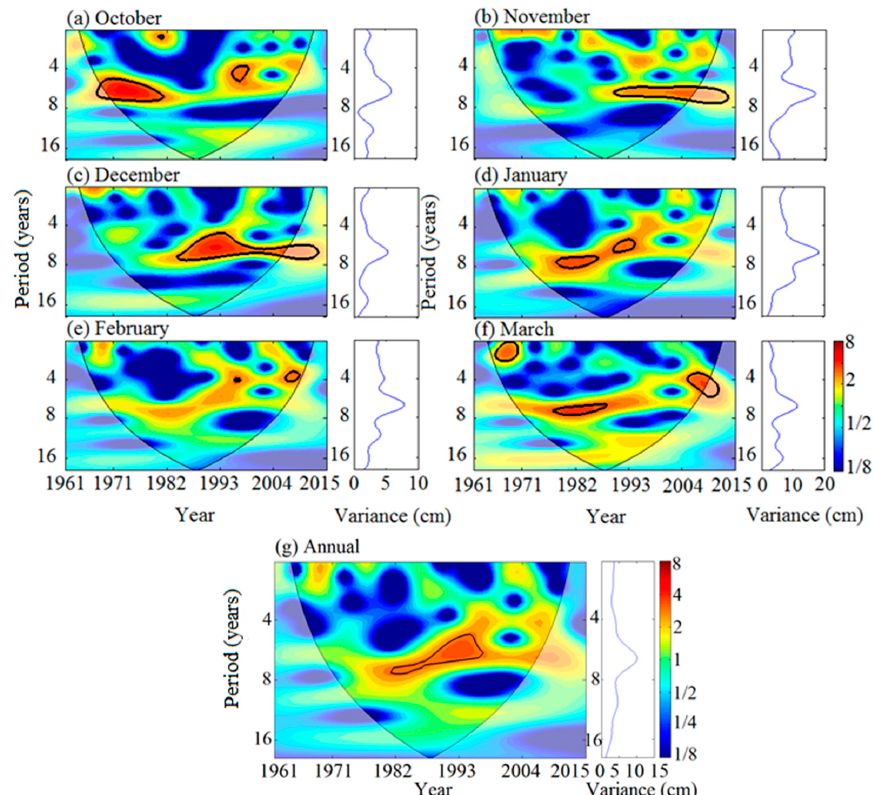
Figure 9. Multi-Morlet wavelet spectrum of monthly and annual snow depths over 1961–2015 at the Aletai station: ( a ) October, ( b ) November, ( c ) December, ( d ) January, ( e ) February ( f ) March and ( g ) Annual.The red and blue colors indicate the peak and valley of the energy density, and the color depth indicates the relative change of the energy density. The black thick solid line is the 95% confidence interval boundary and passes the red noise test. The cone of influence (COI) where edge effects may distort the picture is shown under a thin black curve.